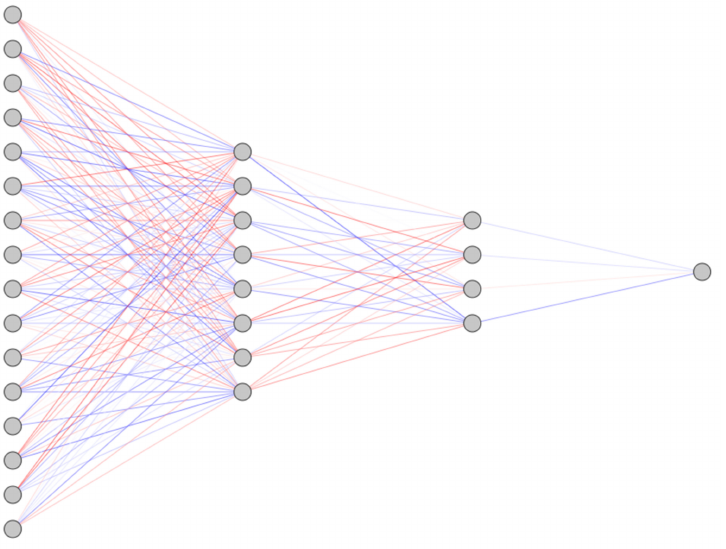
Figure 6. Visualization of feedforward artificial neural network architecture. We have a 16-node input layer followed by two hidden layers of 8 and 4 nodes, respectively. The final layer contains a single output node. At each node, there may be a nonlinear activation function, such as the sigmoid, but each node’s input is the linear combination of connections from the nodes in the preceding layer. Connections between each individual node are visualized: blue edges are negatively weighted, red edges are positively weighted, and edge opacity represents relative magnitude. Weights were initiated randomly for the purpose of visualization. Networks of this type may be used for classification but also for the modeling of highly nonlinear